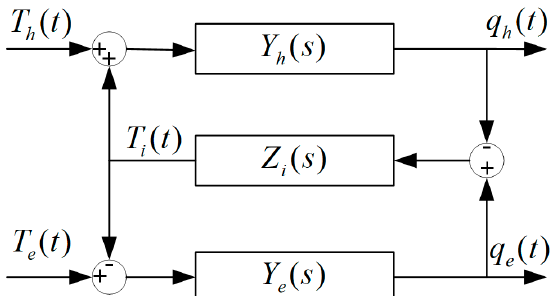
Figure 5. Expression of impedance and admittance of coupling model of the human lower limb and the exoskeleton.